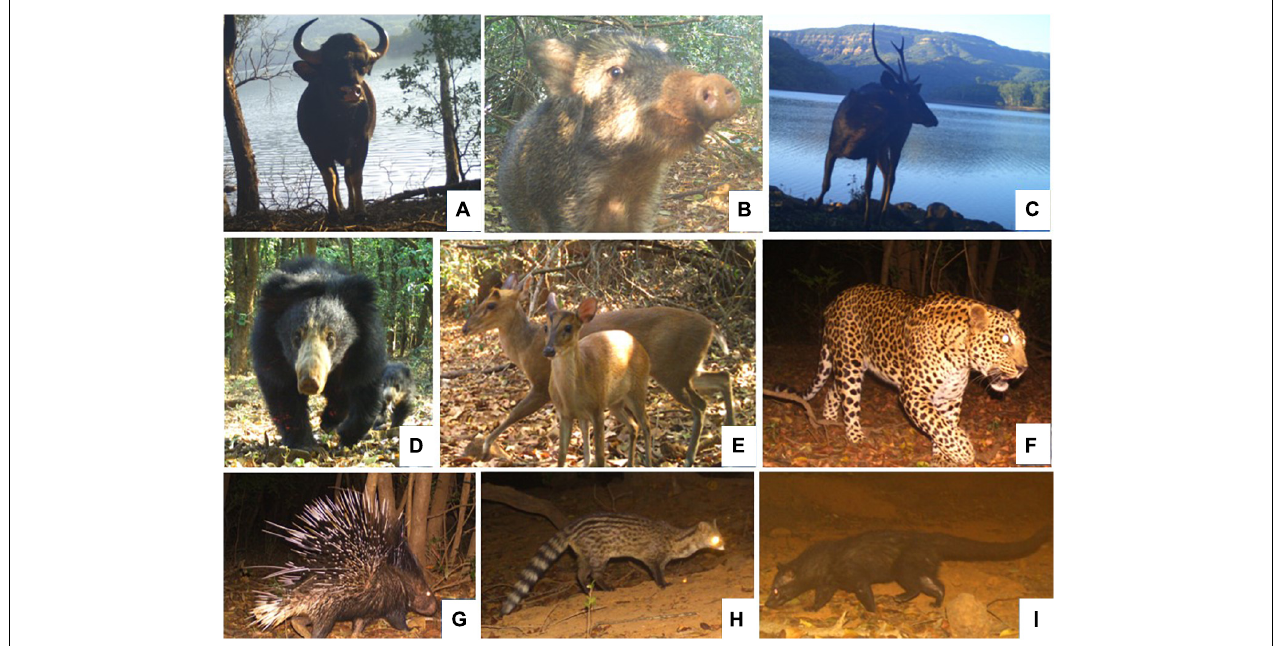
FIGURE 3 | Select camera trap images of highly ‘phot-captured’ mammals during the study. (A) ‘gaur’ Bos gaurus ; (B) wild pig Sus scrofa ; (C) sambar Rusa unicolor ; (D) sloth bear Melursus ursinus ; (E) barking deer Muntiacus ‘muntjac’ ; (F) leopard Panthera pardus ; (G) porcupine Hystrix indica ; (H) small Indian